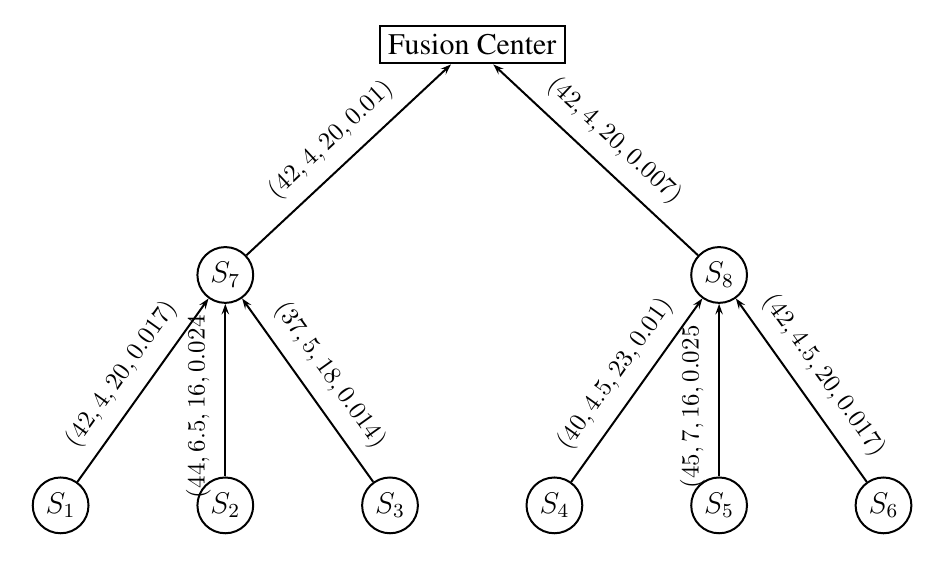
Figure 10. Tree detection network for the example problem. Labels on each edge represent µ , σ , e (in mJ), and the signal to noise ratio, respectively, for each source c c